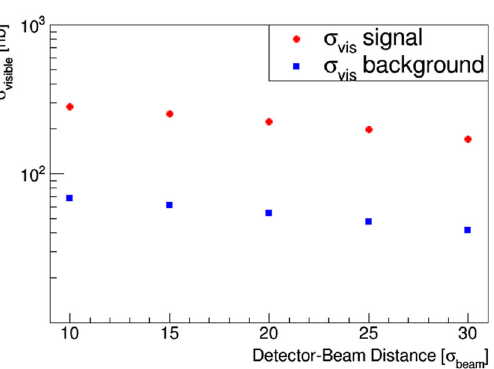
Fig. 11 The visible cross-sections for the signal and background as a function of n for R p = 0 . 5 mm and β ∗ = 90